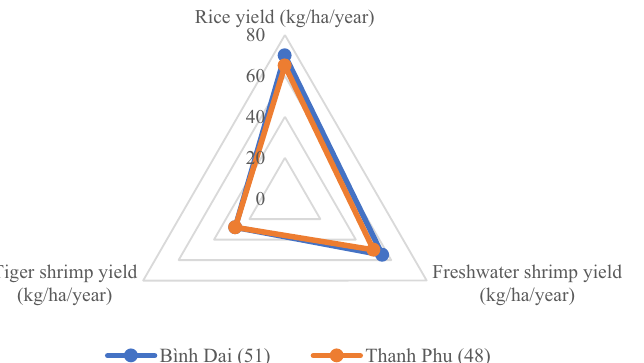
Figure 5. Productivity theme